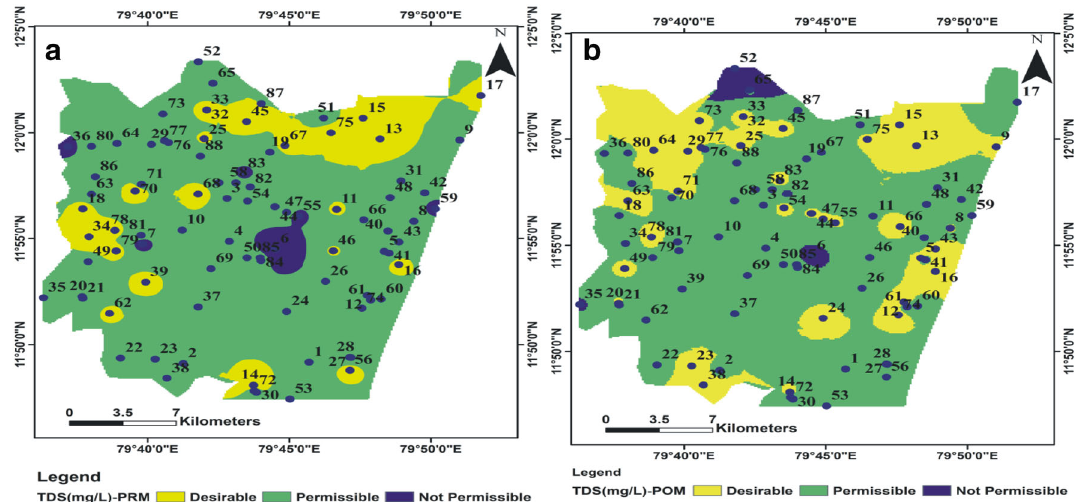
Fig. 5 a , b Spatial distribution map of TDS (pre- and